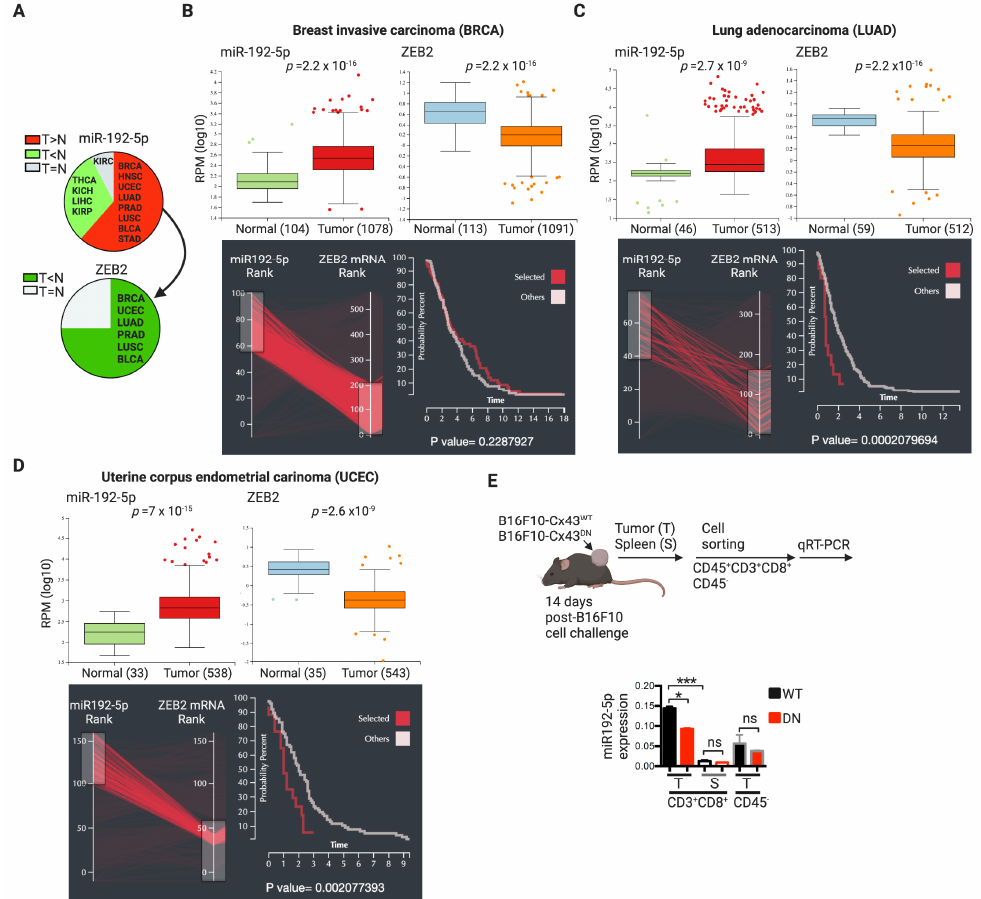
Figure 6. miR-192-5p levels are abundant in human tumors and are higher in CTLs infiltrating B16F10 tumors expressing functional Cx43 channels. ( A ) miR-192-5p is significantly more abundant in 8 out of 13 tumors (T), as compared with the corresponding normal (N) tissue in large cohorts of cancer patients described in The Cancer Genome Atlas (TCGA) dataset analyzed by miRNA Target Viewer (miR-TV) resource (http: // mirtv.ibms.sinica.edu.tw). Six of these eight tumors have an inverse pattern for ZEB2 mRNA expression. ( B – D ) Expression levels of miR-192-5p and its target ZEB2 (mRNA) in tumors and adjacent normal tissues in three di ff erent cancer types described in the TCGA database analyzed by miR-TV resource. Below, each box plot shows the Kaplan-Meier survival curves for patients with the highest miR-192-5p and lower ZEB2 expression (red lines; “selected”), versus the rest (light gray lines, “others”). HNSC: head and neck squamous cell carcinoma; PRAD: prostate adenocarcinoma; LUSC: lung squamous cell carcinoma; BLCA: bladder urothelial carcinoma; STAD: stomach adenocarcinoma; KIRC: kidney renal clear cell carcinoma; THCA: thyroid carcinoma; KICH: kidney chromophobe; LIHC: liver hepatocellular carcinoma; KIRP: kidney renal papillary cell carcinoma. ( E ) C57BL6 mice were challenged subcutaneously with B16F10 cells expressing wild type or a dominant negative Cx43 mutant (Cx43 WT , Cx43 DN , respectively). Tumors (T) and spleens (S) were collected 14 days after tumor challenging, and CD8 + T cells and non-immune (CD45 − ) cells were isolated by fluorescence-activated cell sorting (FACS). RNA samples were obtained from the isolated cells and miR-192-5p expression was analyzed by qRT-PCR. * p < 0.05; *** p < 0.001; ns: non-significant (one-way ANOVA, Tukey’s multiple comparison